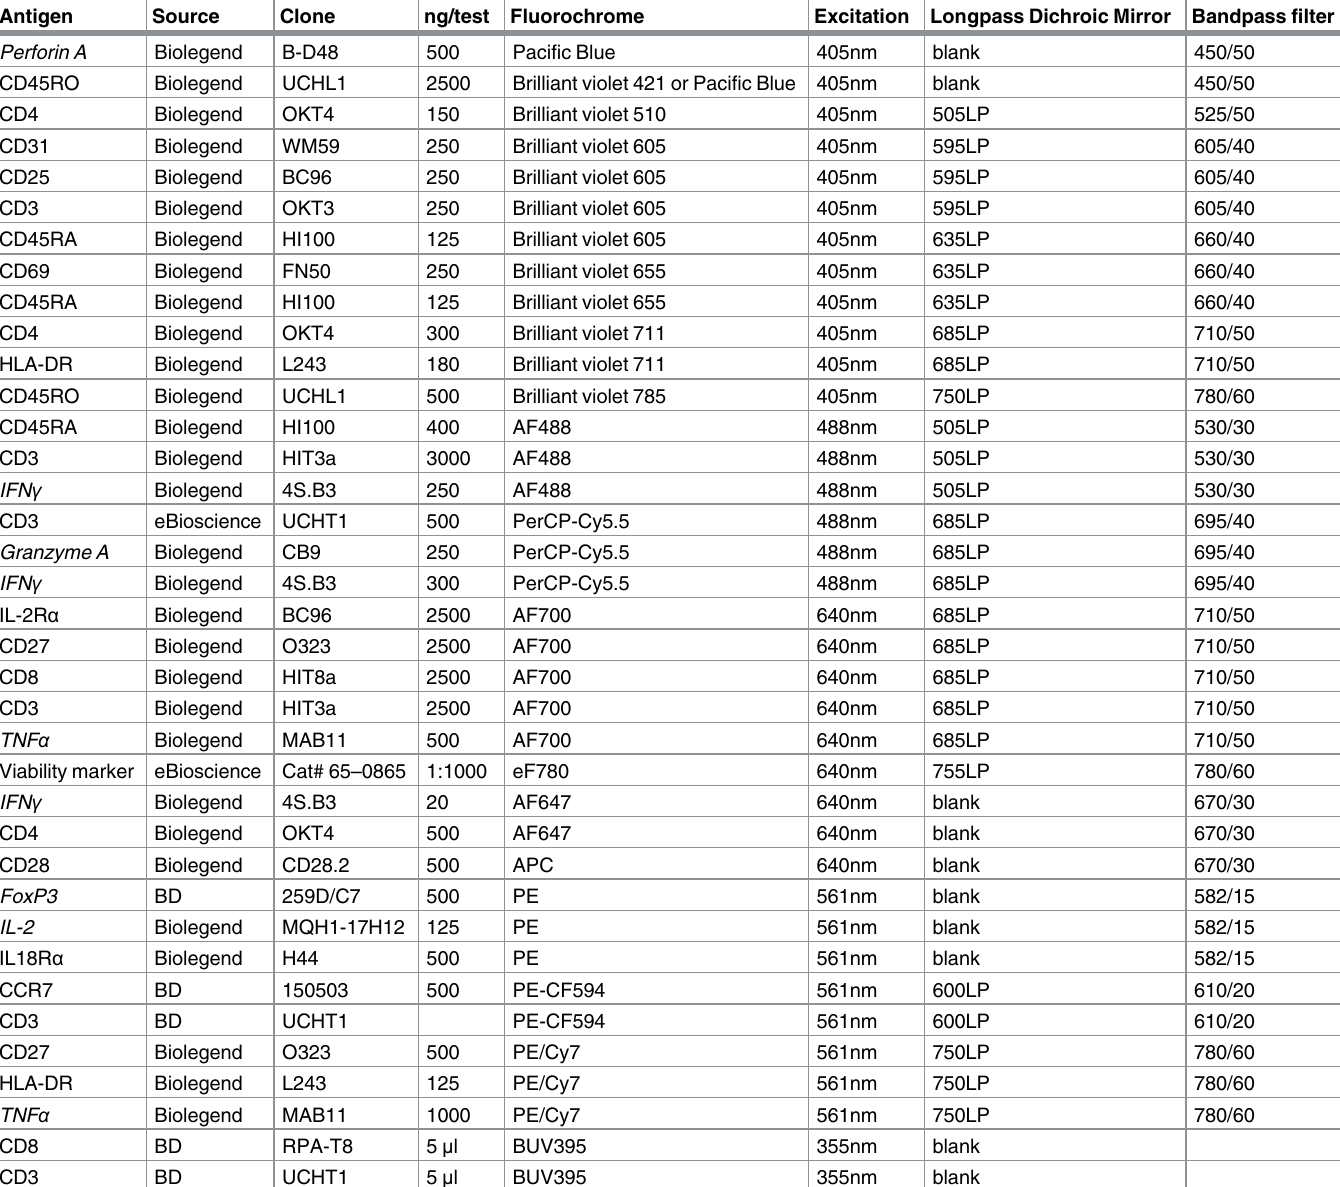
Table 4. Antibodies used for antigen detection. Intracellular/intranuclear antigens are noted in italics